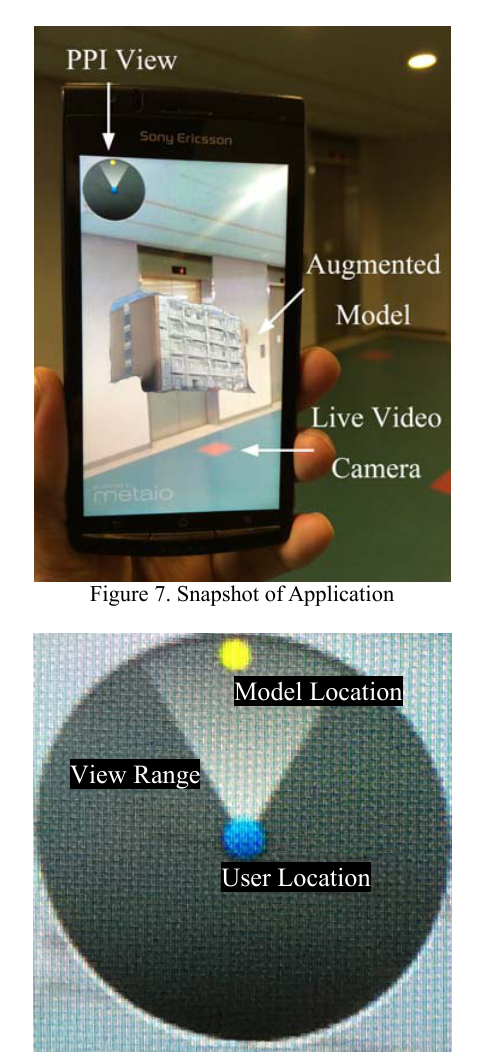
Figure 8. Plan Position